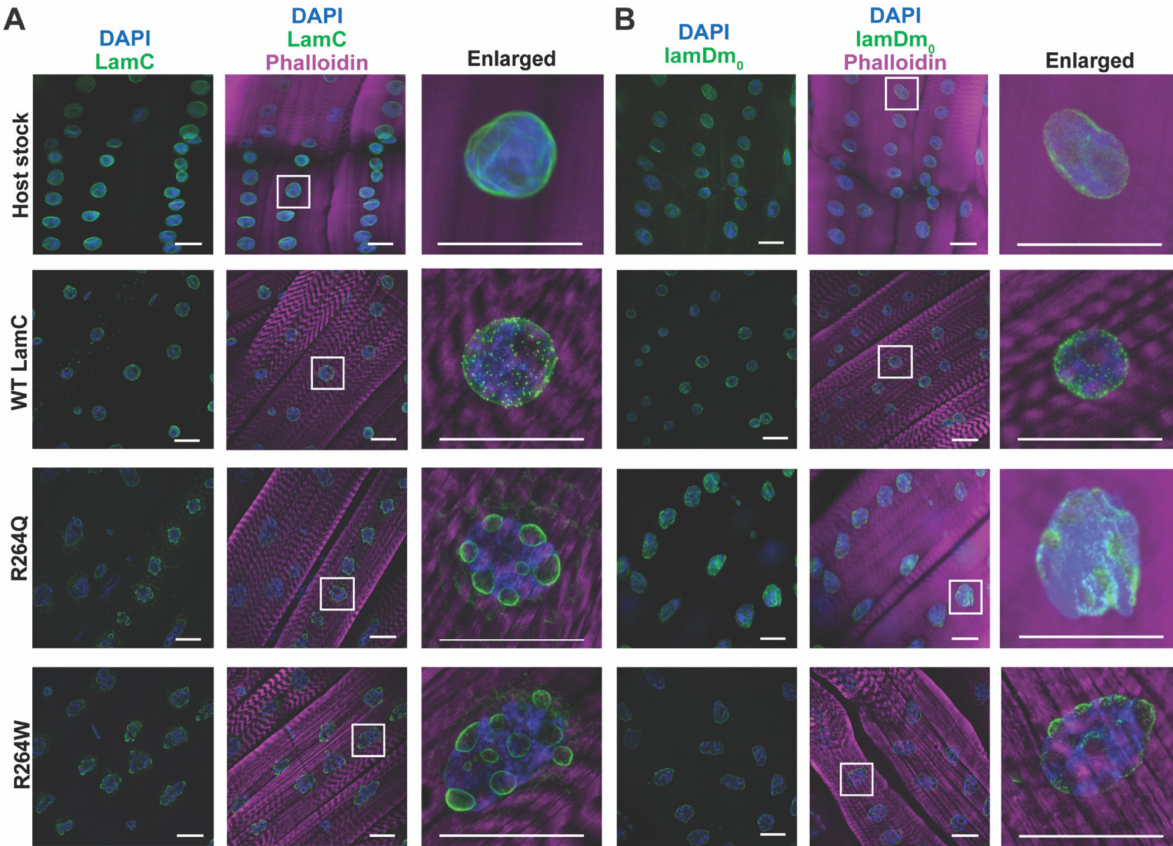
Figure 5. Expression of the LamC R264Q and R264W transgenes caused nuclear deformation. ( A ) Larval body-wall muscles expressing endogenous LamC (host stock), and either a wild-type LamC or mutant LamC transgene were fixed and stained with phalloidin (magenta), DAPI (blue) and antibodies to LamC (green). The scale bar represents 30 µ m. ( B ) Larval body-wall muscles expressing either wild-type or mutant LamC were fixed and stained with phalloidin (magenta), DAPI (blue) and antibodies to lamDm 0 (green). The scale bar represents 30 µ